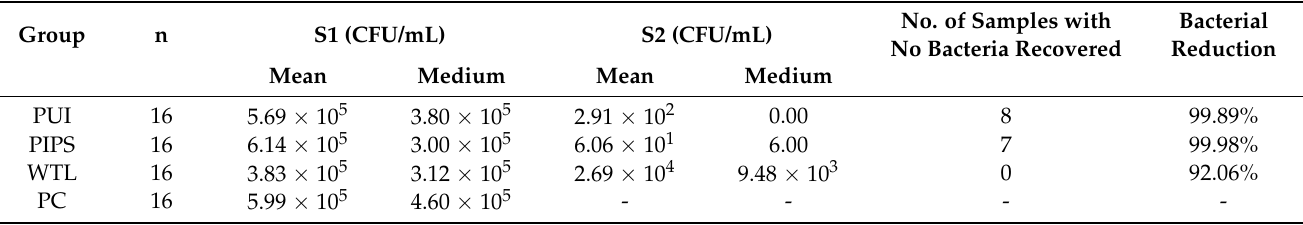
Table 1. Colony-forming units (CFUs) of E. faecalis recovered before (S1) and after (S2) treatment using the paper-point sampling